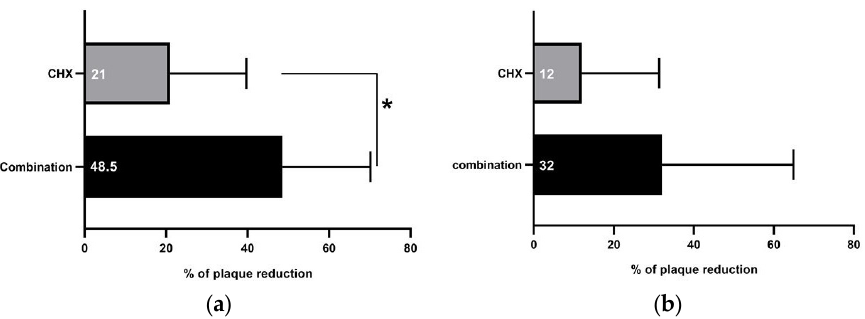
Figure 2. Percentage of plaque reduction after rinsing with combination and 0.12% chlorohexidine (CHX) mouthwashes. ( a ) At teeth sites where samples for GCF influx and resting volume assessments were taken, rinsing with combination mouthwash resulted in significantly more plaque reduction (48.5%) than CHX (21%). ( b ) At teeth sites where samples for IL-1 β concentration assessments were taken, rinsing with both combination and CHX induced plaque reduction (32% and 12%, respectively). * Comparisons by Chi ‐ square test; significance at p < 0.05.